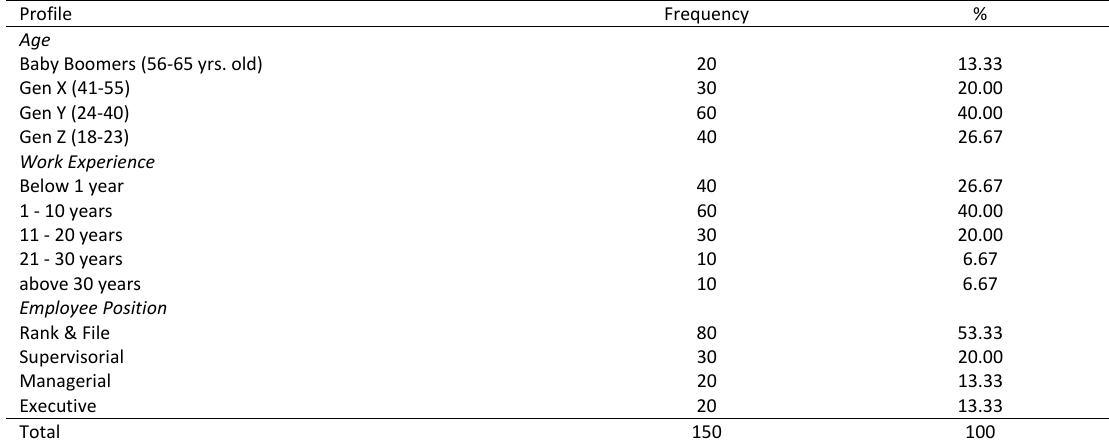
Table 6: Profile of the respondents